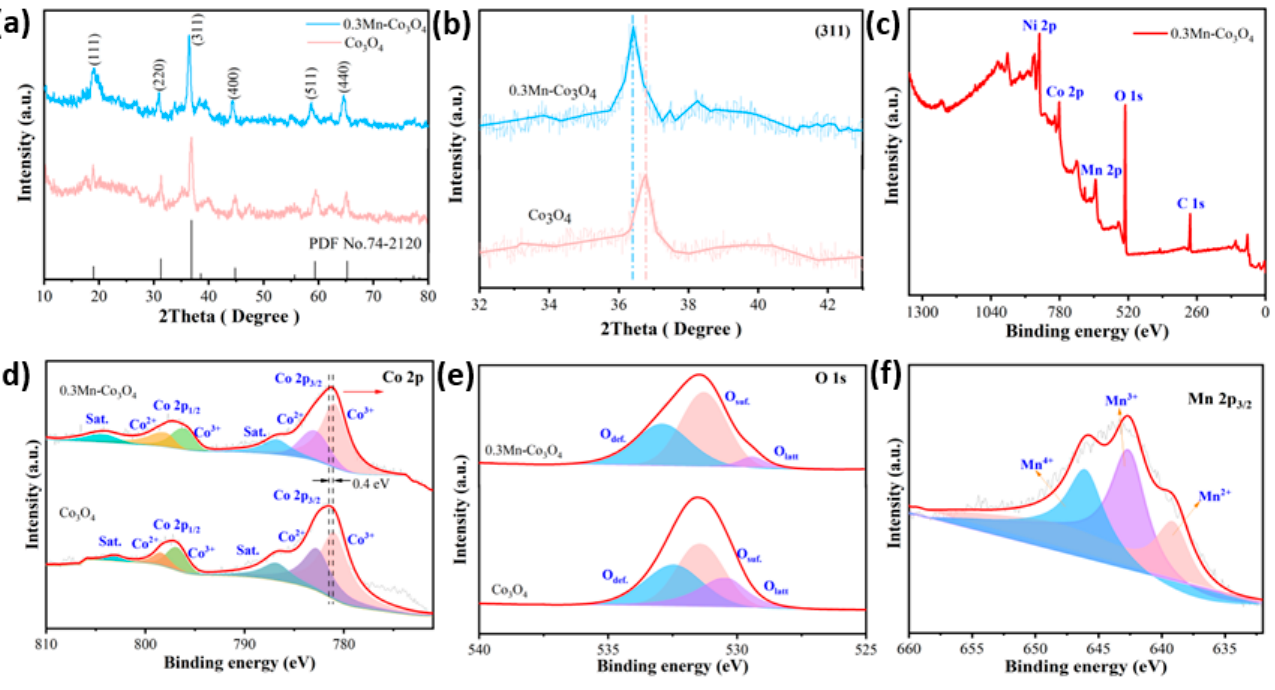
Figure 1. ( a , b ) XRD patterns of the as-prepared samples ( c ) the XPS survey spectra of 0.3Mn-Co 3 O 4 sample ( d ) Co 2p ( e ) O 1s ( f ) Mn 2p.